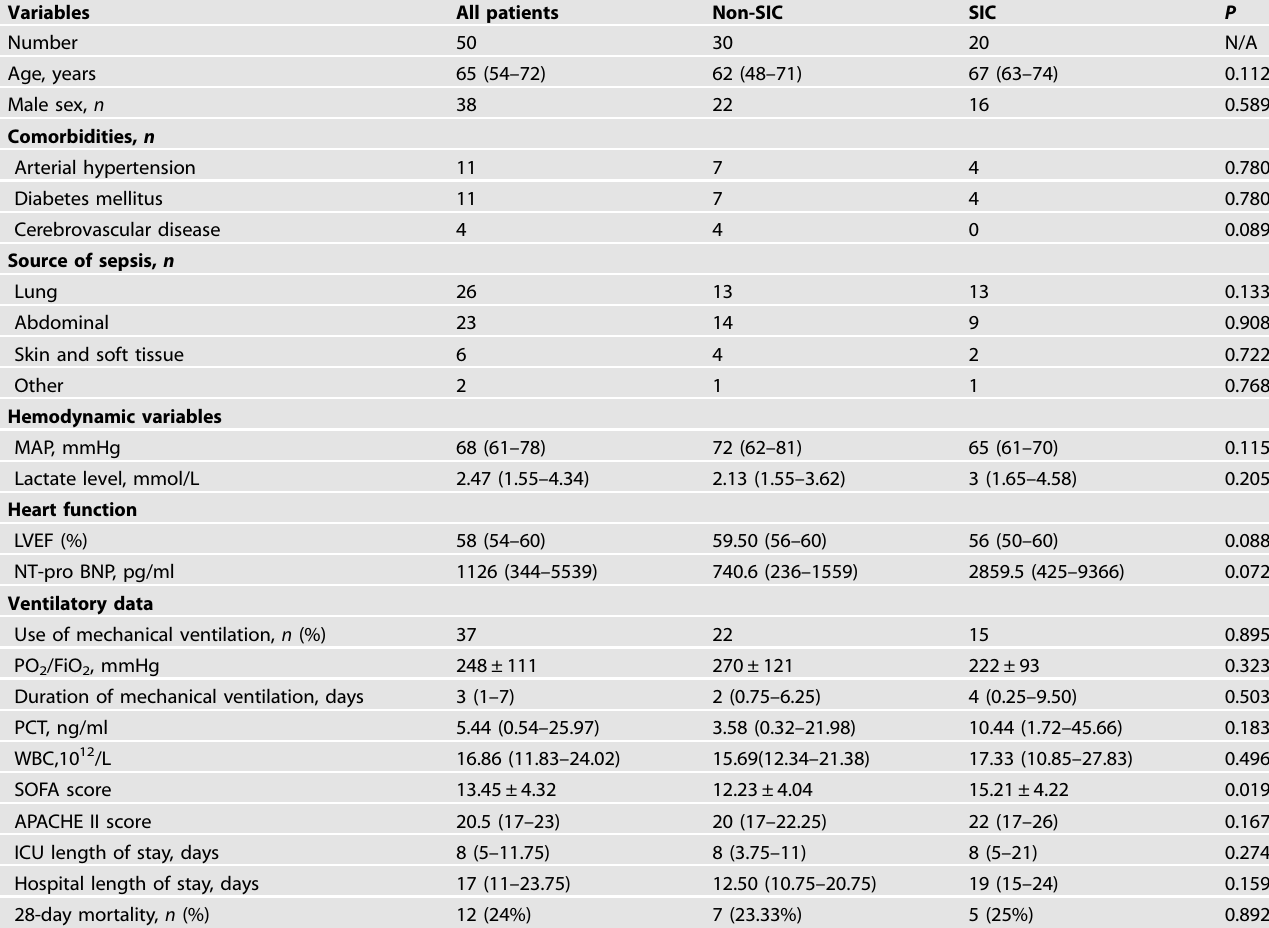
Table 2. The baseline characteristics of all the